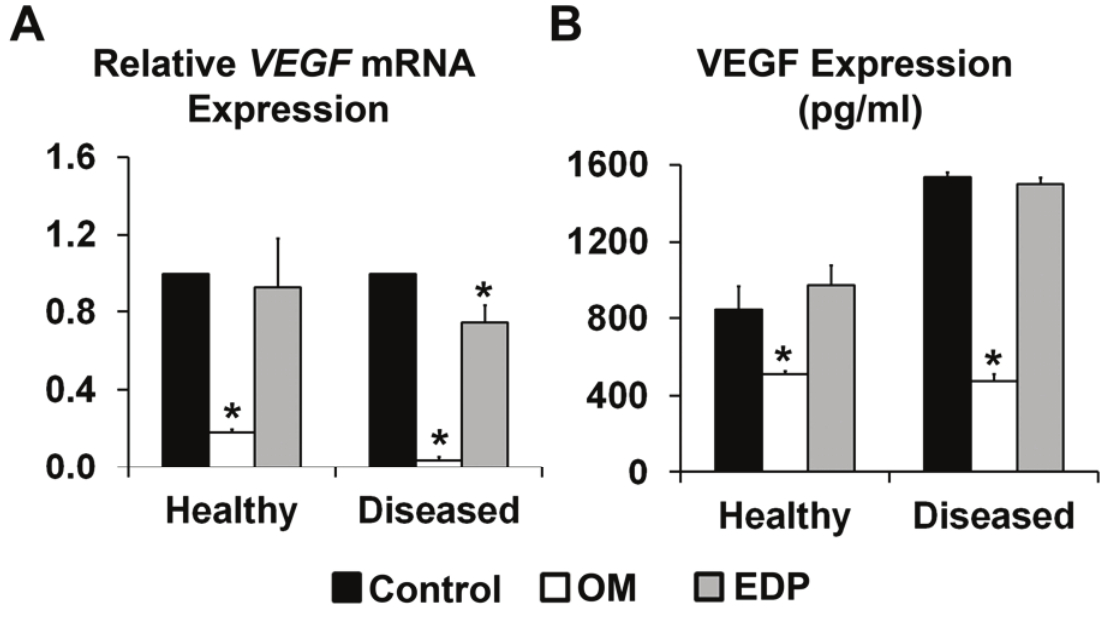
Figure 6. Disease differentially affects VEGFA gene and protein expression levels. In healthy AVICs, treatment with osteogenic media resulted in significant inhibition of both VEGF mRNA ( A ) and protein ( B ) expression, while no effect was observed for EDP. Interestingly, while mRNA levels for VEGFA were similar between healthy and diseased AVICs, the basal levels of VEGFA protein in the diseased group were significantly higher as compared to healthy controls. Further, treatment of diseased cells with osteogenic media resulted in stronger inhibition of VEGFA mRNA and protein expression, as compared to the healthy group. In the disease AVICs, EDP treatment led to a small decrease in VEGFA mRNA, but not protein expression levels, as compared to